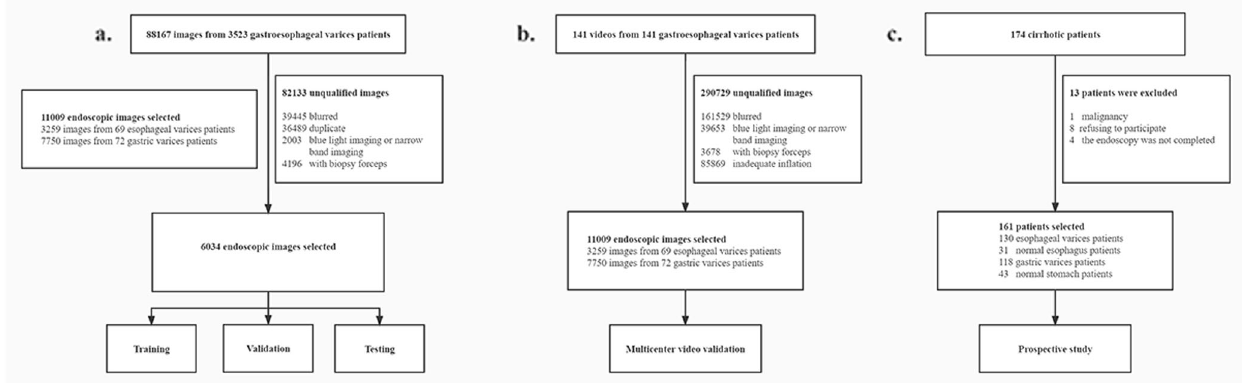
Fig. 1 The fl owchart of research. a Data processing of dataset 1(Training, validation and testing). b Data processing of dataset 2(Validation dataset). c Data processing of dataset 3(Prospective